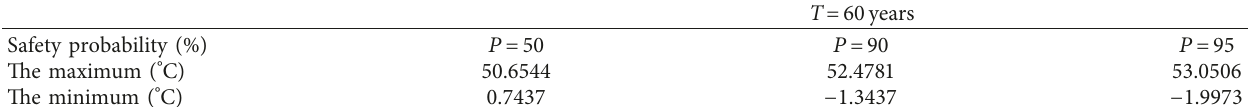
Table 2: Axial uniform temperature based on different safety probability percentages.